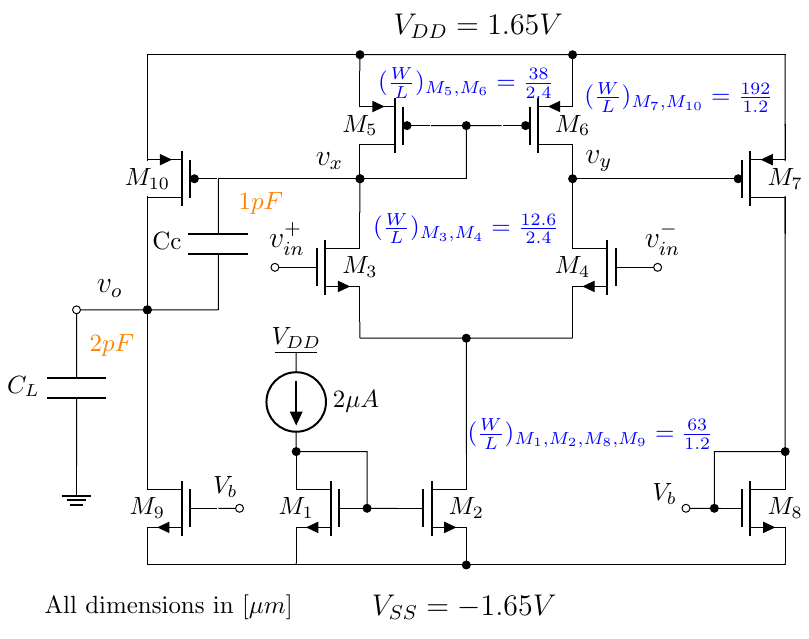
Figure 5. Proposed